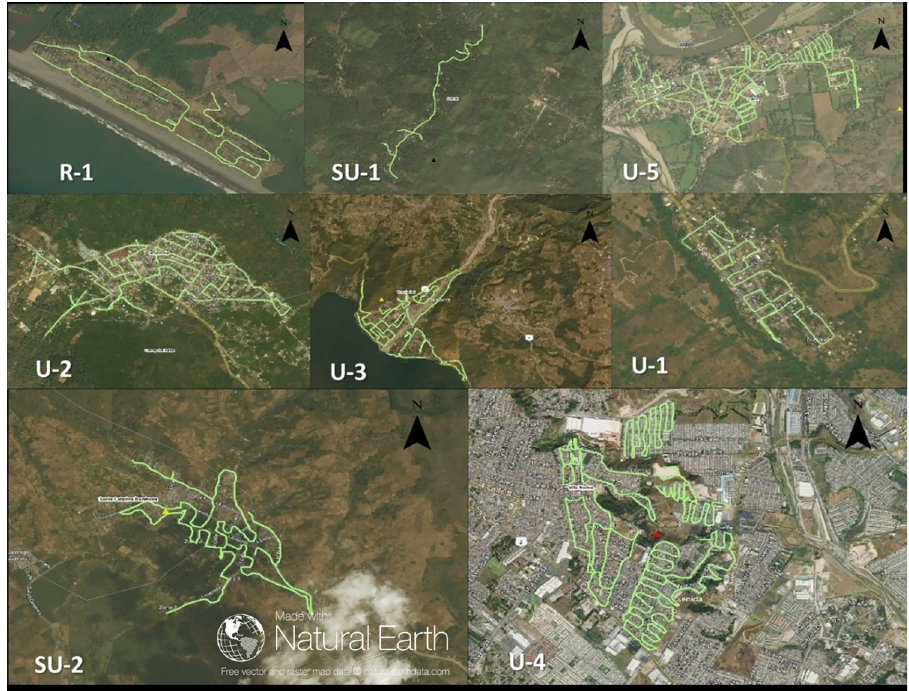
Fig 2. Free roaming counting transects path for SRS method in the study sites. (Base map and data from OpenStreetMap and OpenStreetMap Foundation, and contains information from OpenStreetMap and OpenStreetMap Foundation, which is made available under the Open Database License; https://www.openstreetmap. org/; https://www.openstreetmap.org/copyright). Yellow lines indicates the transect path in the SRS surveys at the study sites. Sites code: R-1 = Chuiririn, SU-1 = El Rosario Patulul, U-5 = Gualan, U-2 = Jacaltenango, U- 3 = Panajachel, U-1 = Petatan, SU-2 = Barahona, U-4 = VillaNueva.